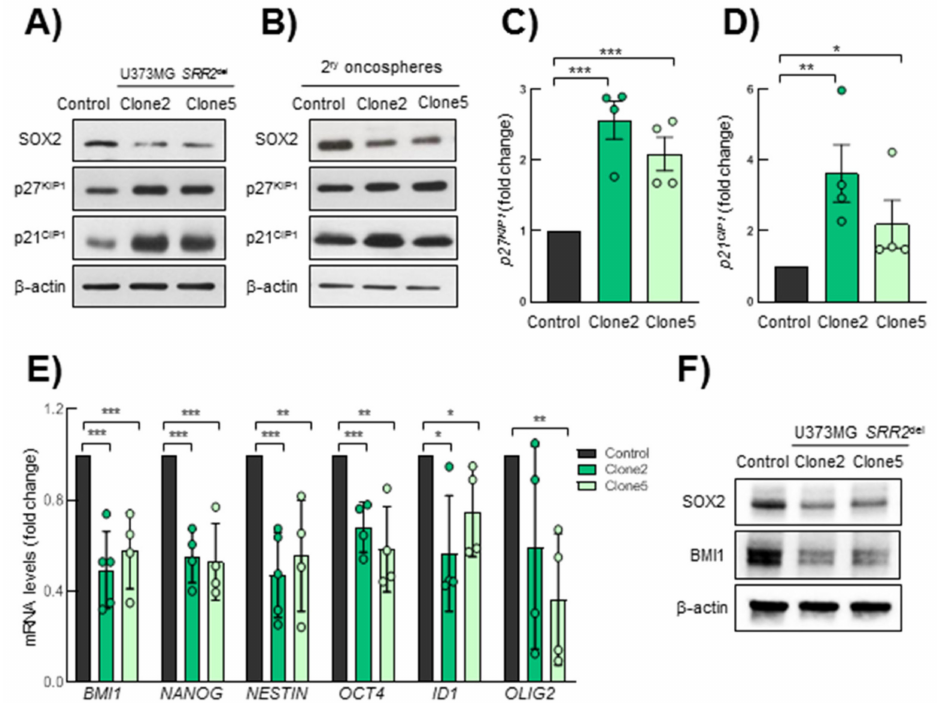
Figure 5. SRR2 -deleted cells show higher p21 CIP1 and p27 KIP1 levels. ( A ) Representative immunoblots of SOX2, p27 KIP1 and p21 CIP1 in U373MG control, SRR2 del clone2 and clone5 cells. ( B ) Representative immunoblots of SOX2, p27 KIP1